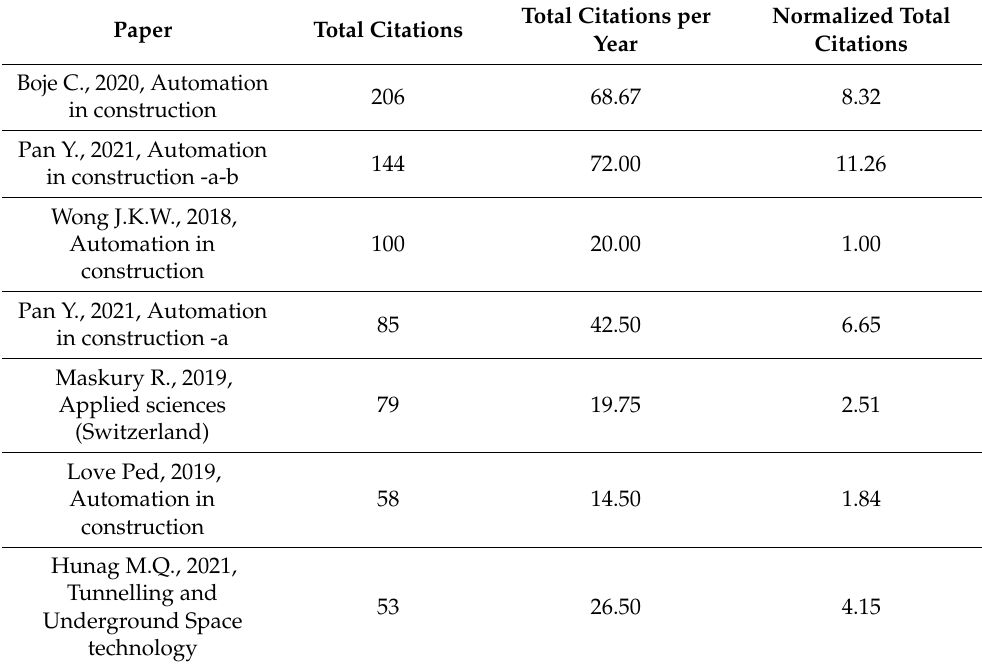
Table 7. Most cited documents analysis performed with Biblioshiny version